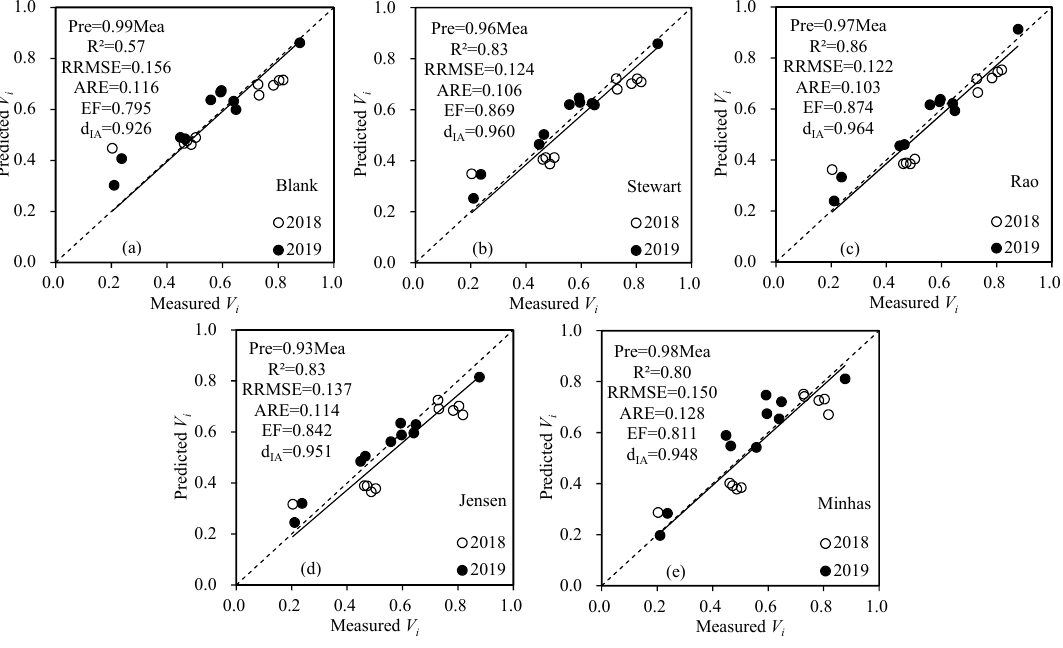
Figure 4. The validation results of the Blank ( a ), Stewart ( b ), Rao ( c ), Jensen ( d ), and Minhas ( e ) models. Model parameters were validated using data of 20 irrigation treatments in 2018 and 2019. The dotted line indicates the 1:1 line. V i , seed vigor evaluated by combinational evaluation method; R 2 , determination coefficients; RRMSE, relative root-mean-square error; ARE, average relative error; EF, modeling efficiency; d IA , agreement index.